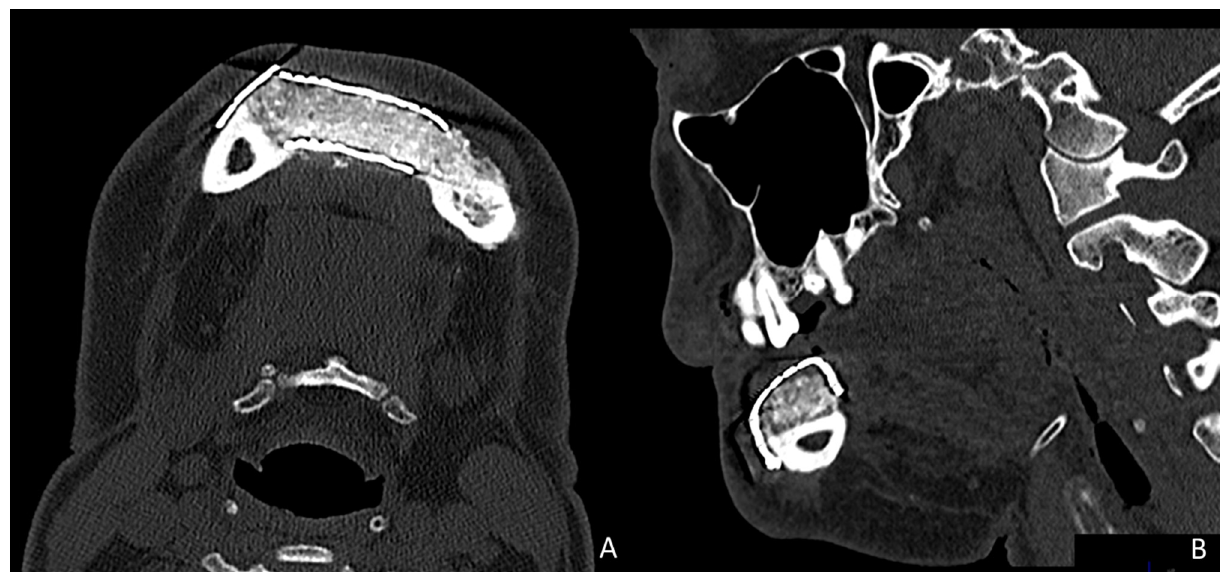
Figure 7. Postoperative CT scan. ( A ) Axial CT Scan demonstrating the stability of the transverse dimension of the fibula with respect to the remnant mandible. ( B ) The three-dimensional preservation of the iliac crest graft with CAD/CAM mesh makes it possible to double the height of the fibula.